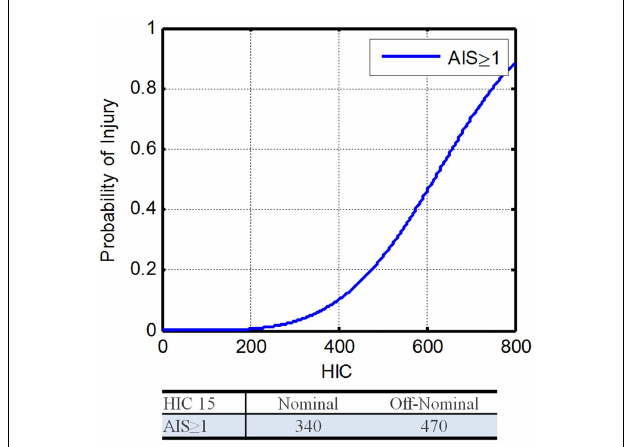
FIGURE 2 | Head injury criteria 15 injury risk function (Funk et al., 2007)